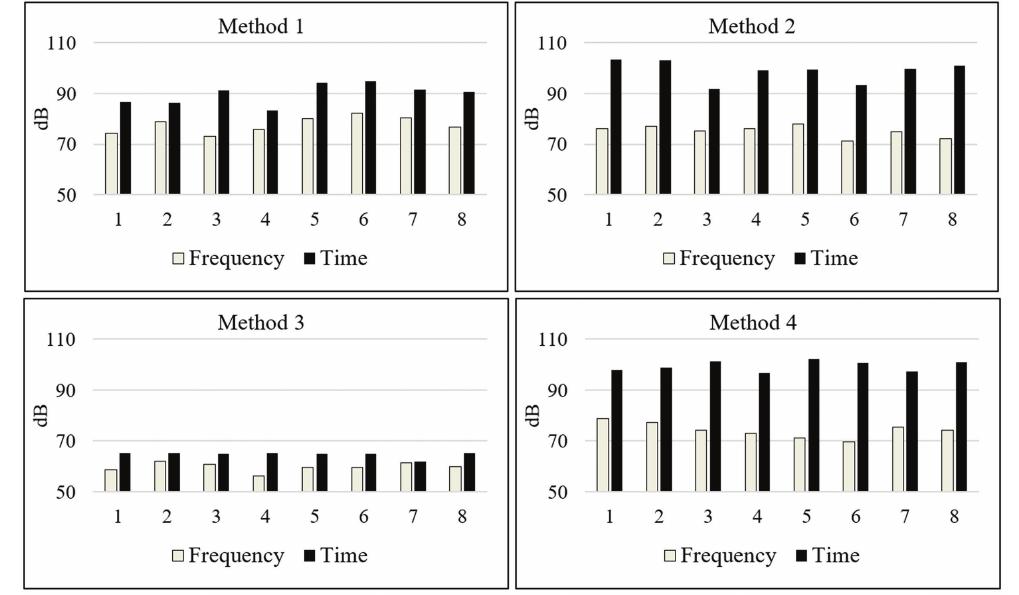
Figure 12. Comparison of Mechanical Impedance between frequency and time domain with the four methods